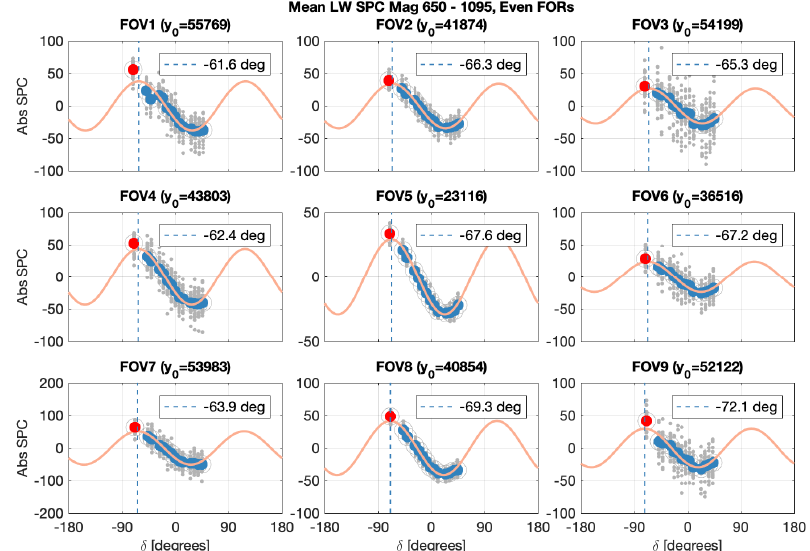
Figure 13. Longwave band average of NOAA-20 magnitude spectra during the pitch maneuver. The blue dots represent the mean over the analysis period for the normally Earth observing cross-track fields of regard, the red dots are the mean for the deep space view, and the smaller grey markers correspond to the individual band-averaged measurements. Only the even-numbered cross-track fields of regard and the deep space view with the same interferometer sweep direction are shown in this figure but the same behavior was also observed for the opposite interferometer sweep direction.